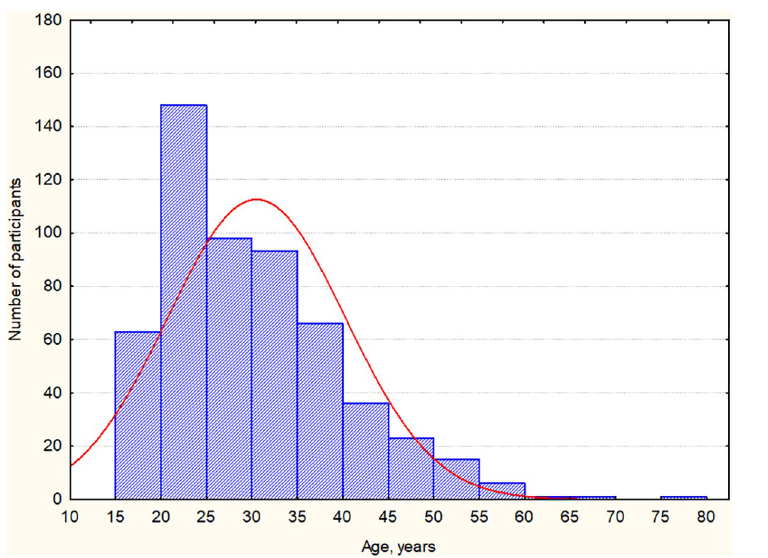
Fig 1. Age distribution for Study 3